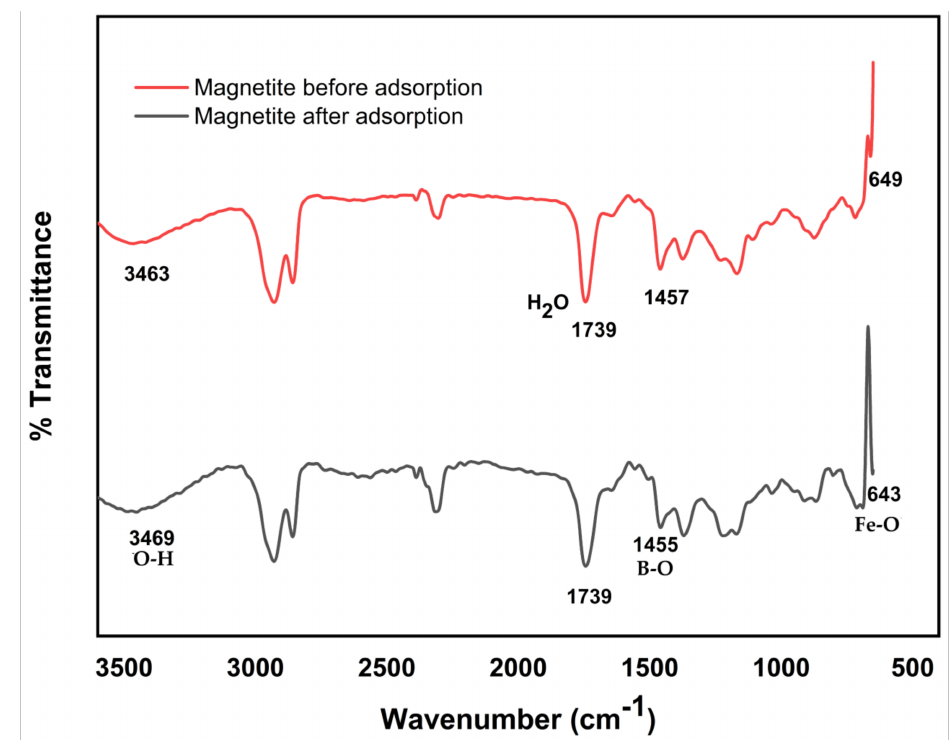
Figure 2. FTIR (Fourier-transform infrared spectroscopy) analysis of magnetite before and after adsorption of